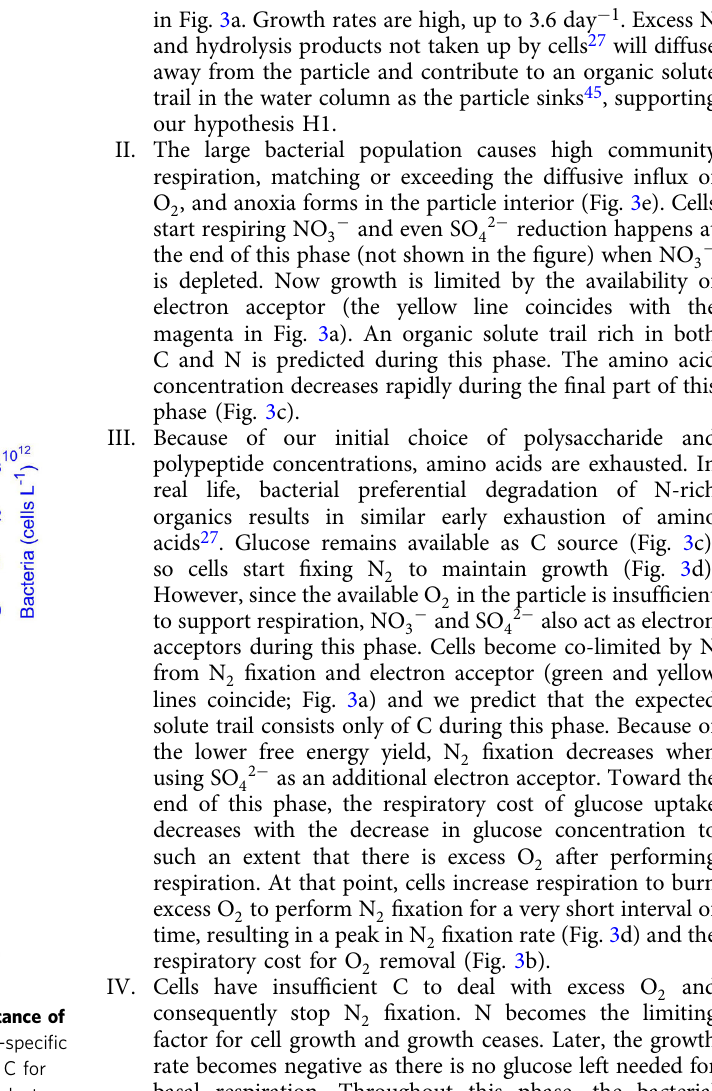
over time at a radial distance of 0.027 cm from the particle center (Fig. 3). We identify four phases: (I) C limited phase, (II) high fi xing phase, and (IV) fading phase. The respiration phase, (III) N 2 different phases are based on limitations of either C or N or electron acceptor where the growth rate is determined by the minimum availability of these three substances (Eqs. 28 and 29; Fig. 3a). Available C for growth is the C remaining from total C uptake after paying the respiratory costs, whereas the N available for growth fi xation. A stepwise conceptual fl ow comes from uptake and N 2 chart of how different factors are responsible for different events inside particles is provided in Supplementary Fig. S3. I. Due to high respiratory cost, cells are limited by C, which is seen by the light blue line coinciding with the magenta line